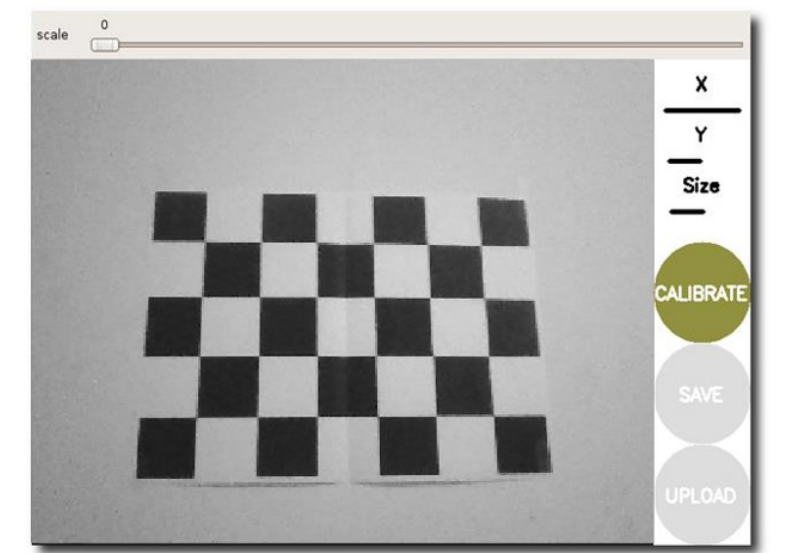
Fig. 2. The window interface of the camera calibration